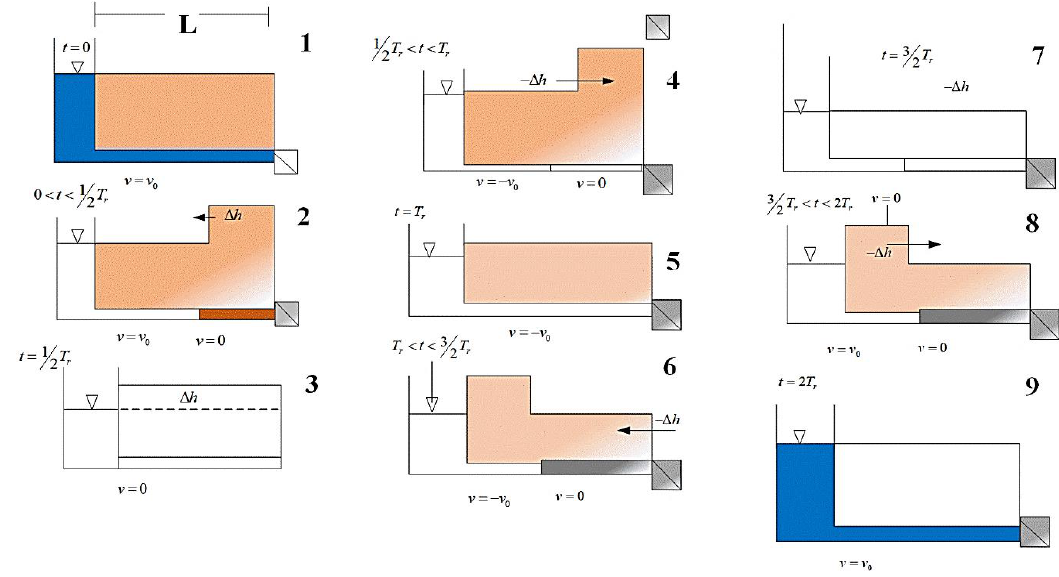
Figure 1. Pressure and velocity waves in a single-conduit, frictionless pipeline following its sudden